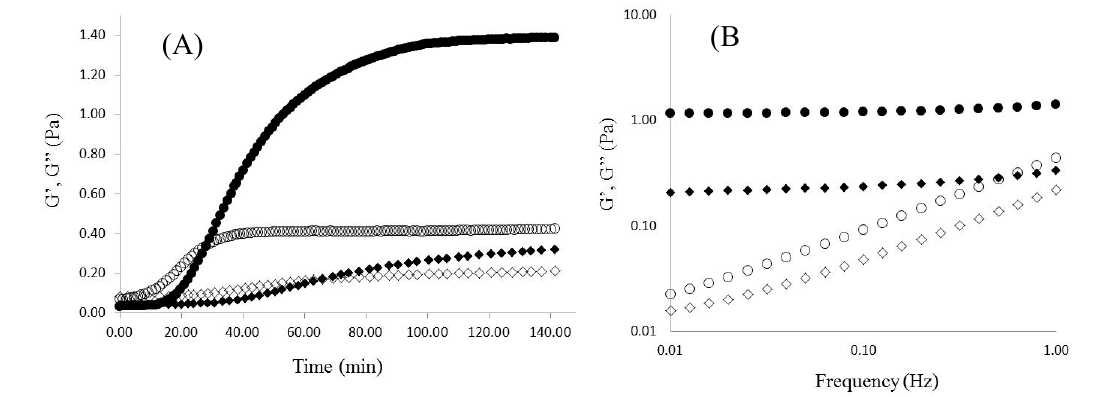
Figure 3. ( A ) Rheological kinetics of 1% ( w / v ) WEAX solution gelation by laccase, measurements at 25 °C, 1 Hz and 10% strain; ( B ) Mechanical spectrum of WEAX gel, measurements at 25 °C, 1 Hz and 10% strain. WEAX G’ (○), G” (●) and WEAX containing yeast G’ ( ), G” (